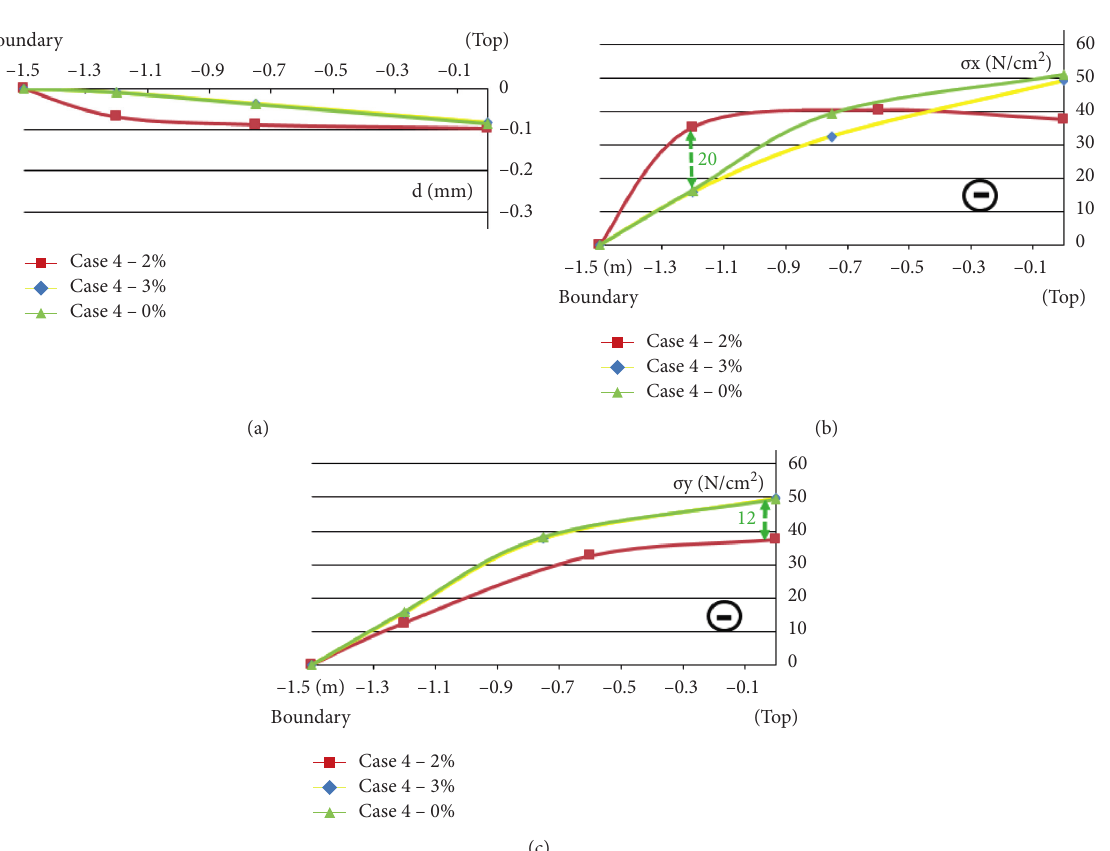
Figure 18: The change of percentage of steel fibres in concrete (Case 3): (a) vertical displacement of the shell; (b) stress σ σ y of shell.